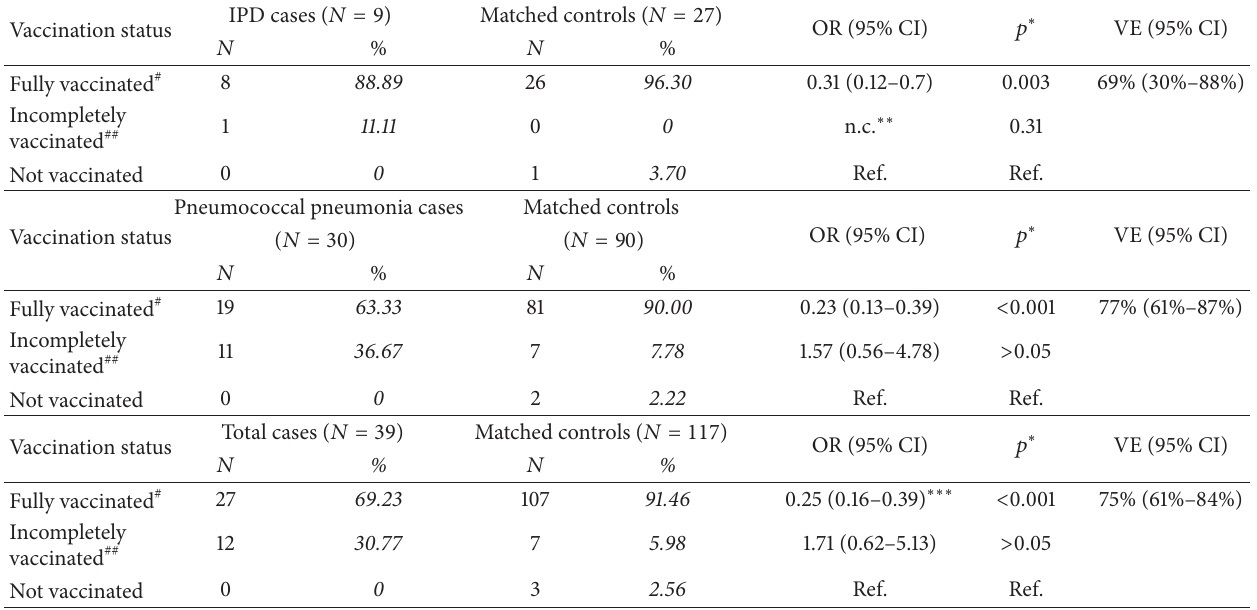
Table 2: Cases of IPD and pneumococcal pneumonia and matched controls. PCVs effectiveness (95% CIs) in Puglia, 2006–2012.